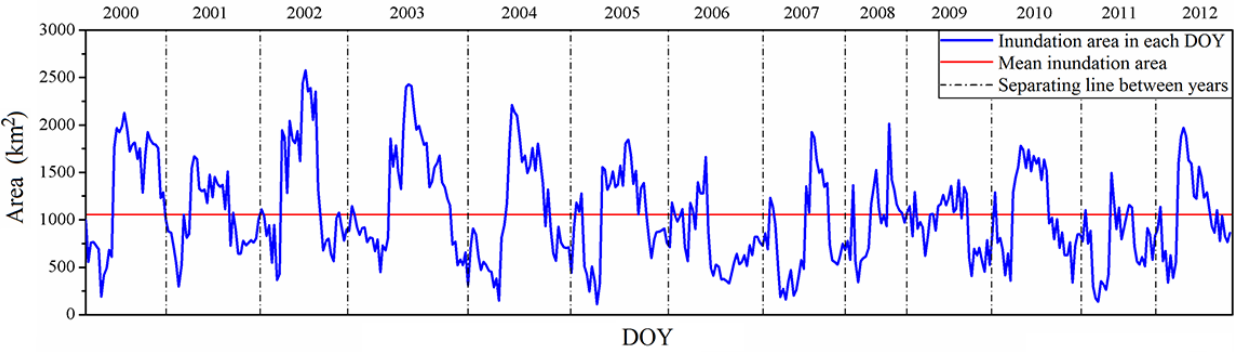
Figure 3. Temporal variations in inundation areas obtained from MODIS images between February 2000 and December 2012 in the Dongting Lake. The red line indicates the mean inundation area over the period from 2000 to 2012, and the dash dotted lines denote separating lines between